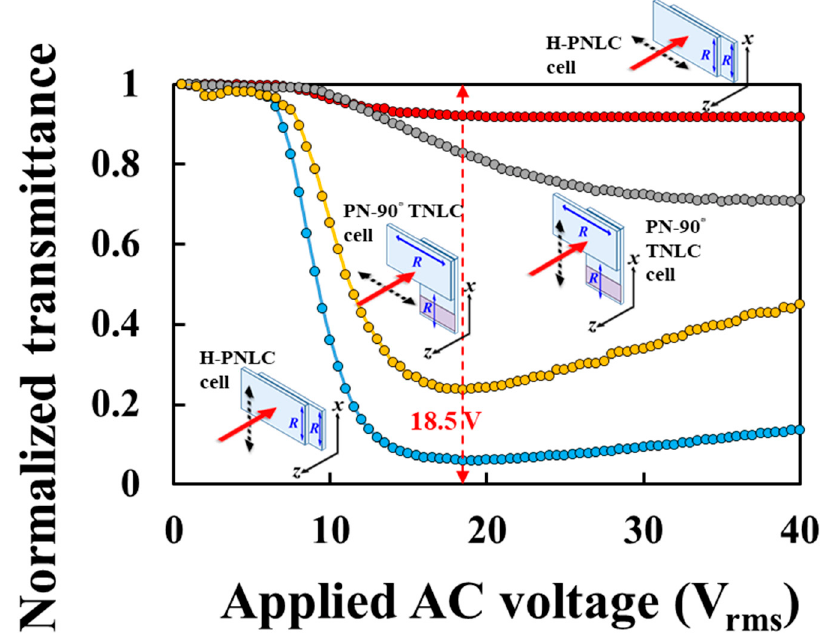
Figure 6. Transmittance as a function of the applied AC voltage curves of the H-PNLC and the PN-90 ◦